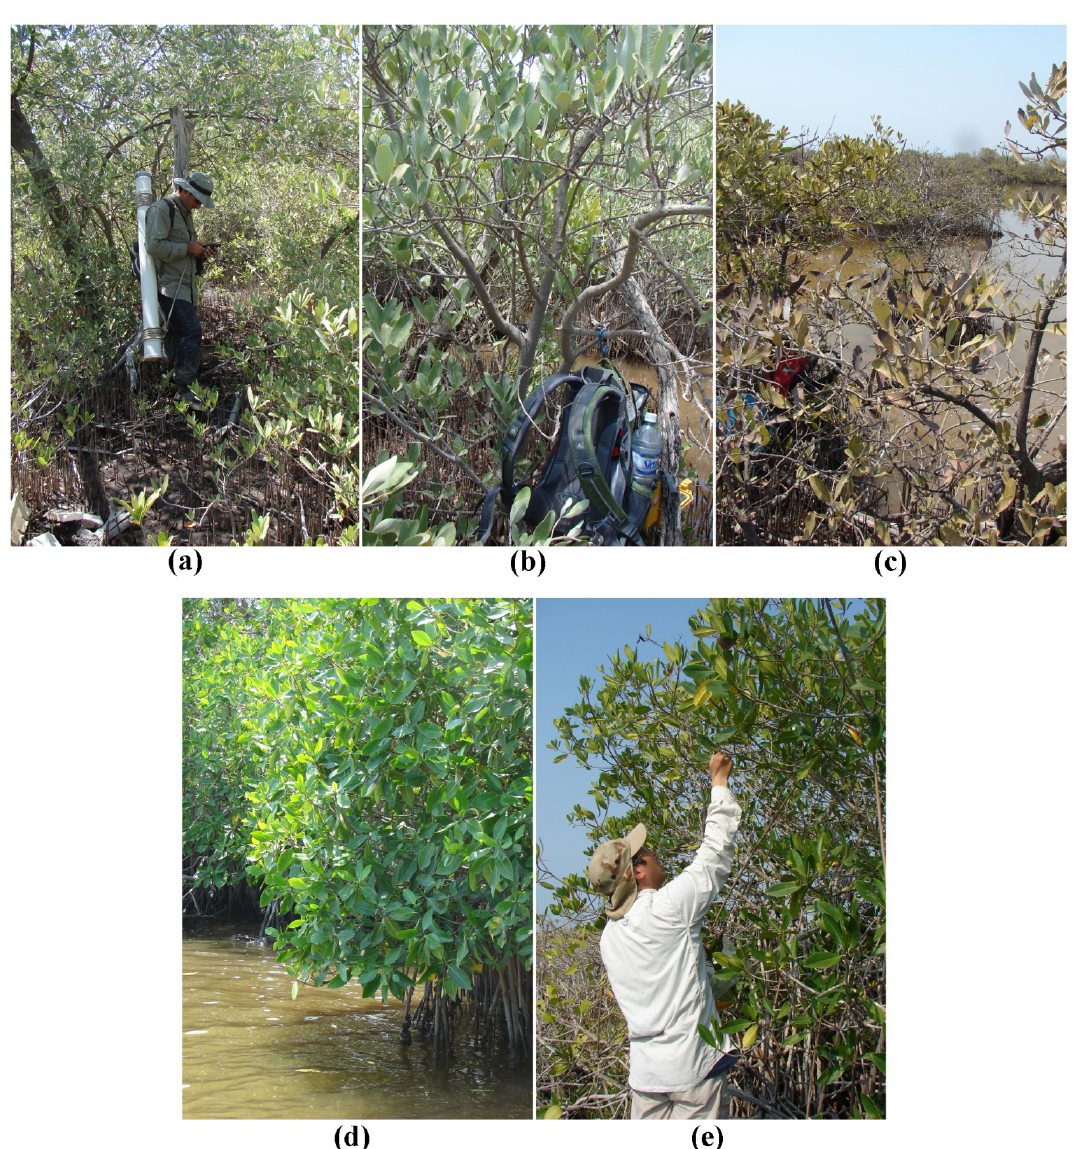
Figure 2. Types of mangrove sampled. From left to right: ( a ) healthy black mangrove ( Avicennia germinans ), ( b ) dwarf black mangrove, ( c ) poor condition black mangrove, ( d ) healthy red mangrove ( Rhizophora mangle ), ( e ) poor condition red